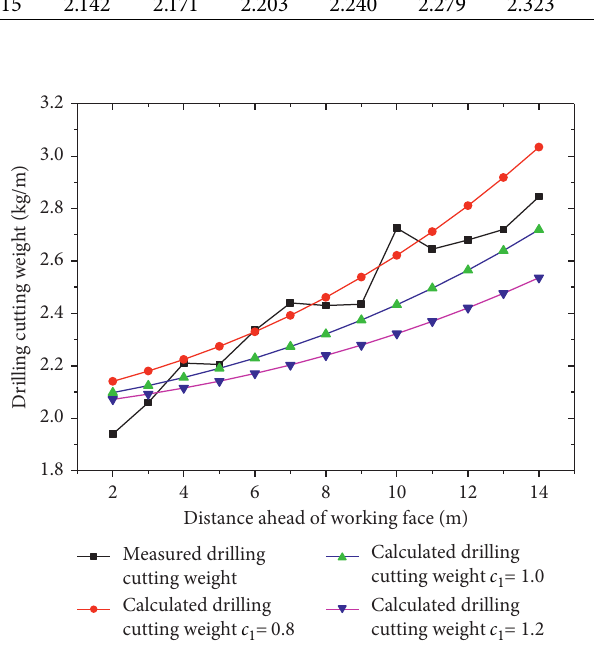
Figure 7: Comparison of actual field measured cutting weight and theoretical calculated cutting weight. Table 7: The total drilling cutting weight under different stress in laboratory experiment. σ v (MPa)